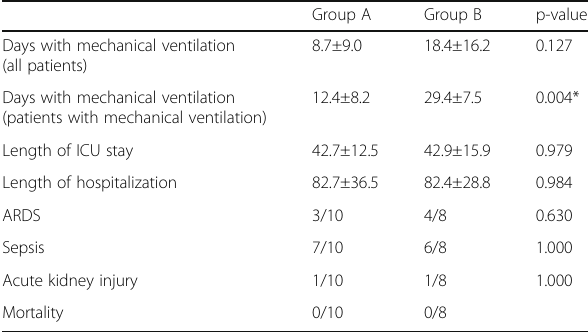
Table 95 (abstract A299). Patient Outcomes